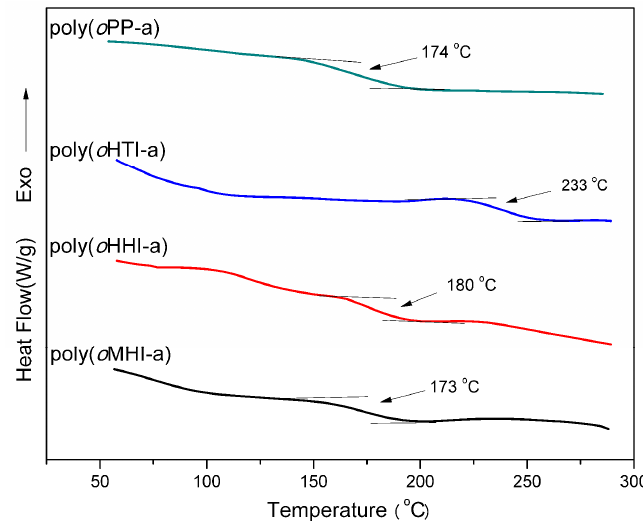
Figure 8. DSC thermograms of polybenzoxazines recorded under nitrogen at a heating rate of 10 °C/min.